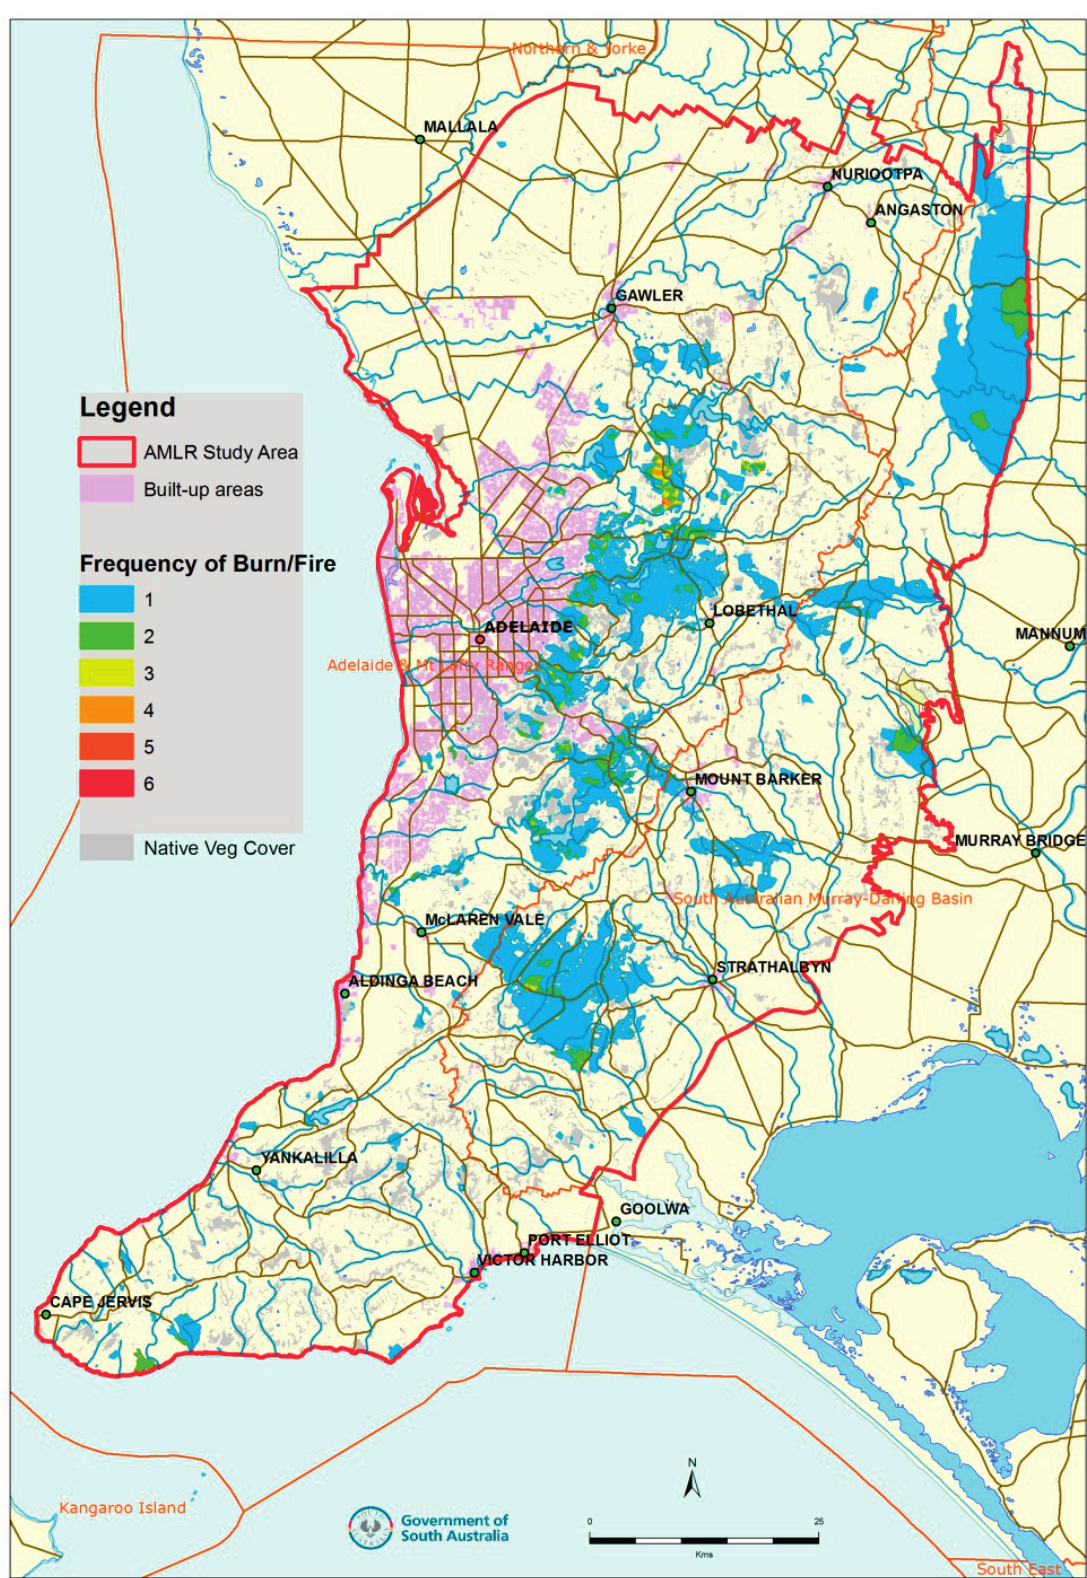
Figure 1. The Adelaide-Mt Lofty Region Study Area (bounded by the red line). The “frequency of burn/fire” is the number of times fires—prescribed “burns” or unplanned fires—have been recorded since 1951–1952 and up to 2013–2014. Records may be incomplete, particularly for small fires and fires on private